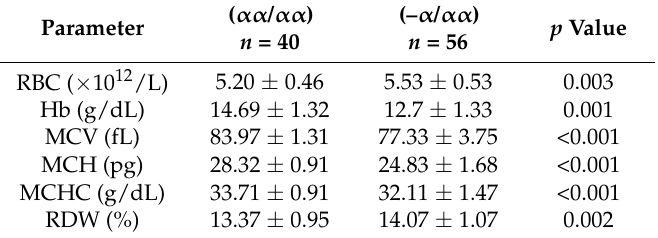
Table 2. Comparison of hematologic parameters of heterozygous α + thalassemia (– α / αα ) and normal controls without α + thalassemia ( αα / αα ). Data represent mean ± SD (standard deviation). p values less than 0.05 were considered statistically